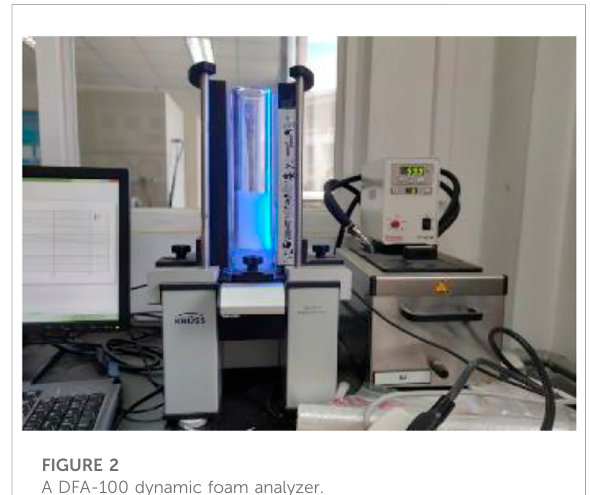
FIGURE 2 A DFA-100 dynamic foam